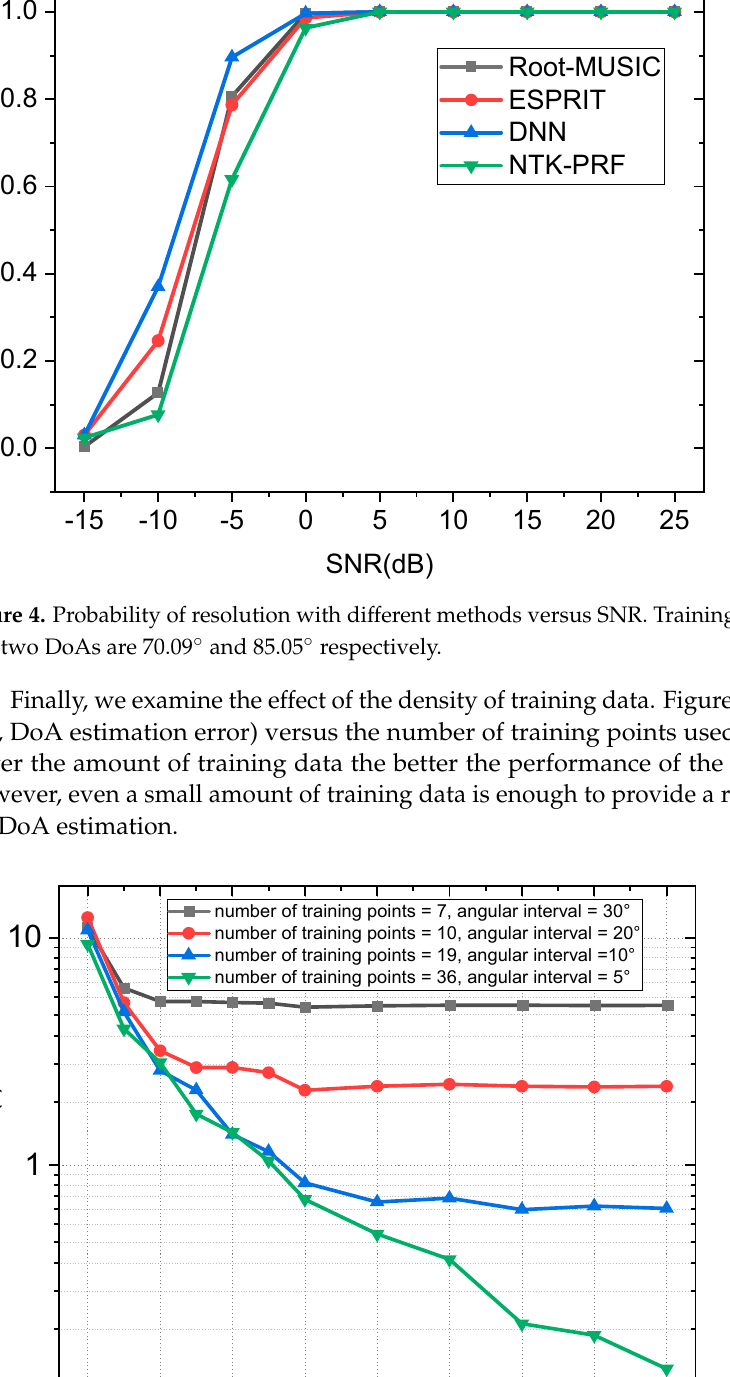
Figure 5. NTK-PRF RMSE vs. training data. Test data at every 0.18° has been used.